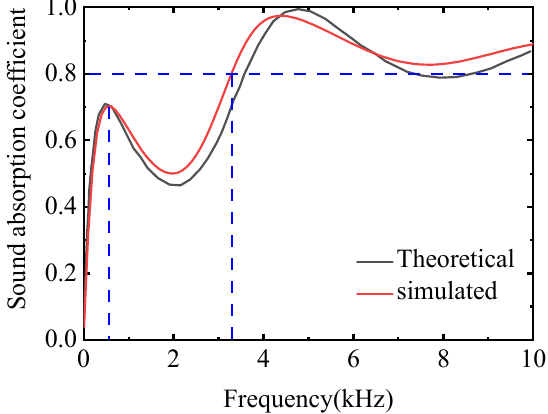
Figure 4. Comparison of α between SSC theoretical model and finite element model.